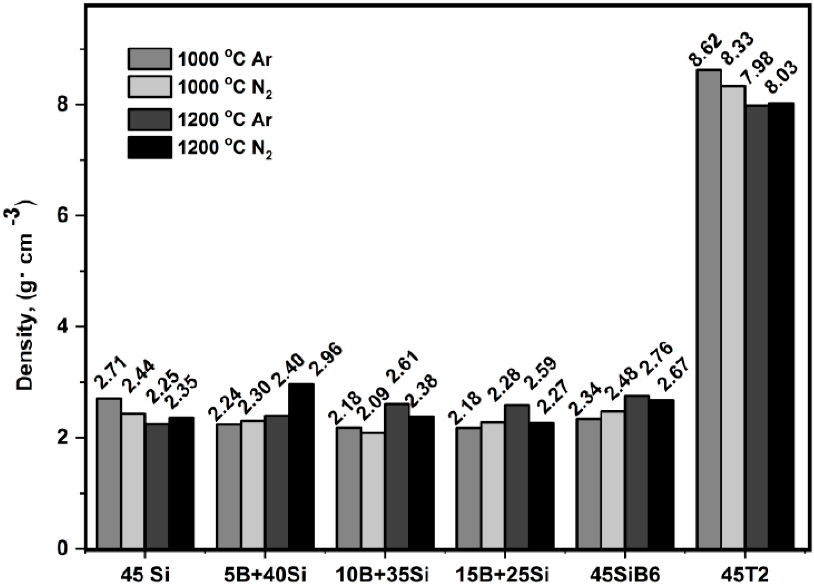
Figure 2. Skeletal density of bulk samples of the filler loaded coating systems after pyrolysis in Ar and in N 2 at 1000 °C and 1200 °C.